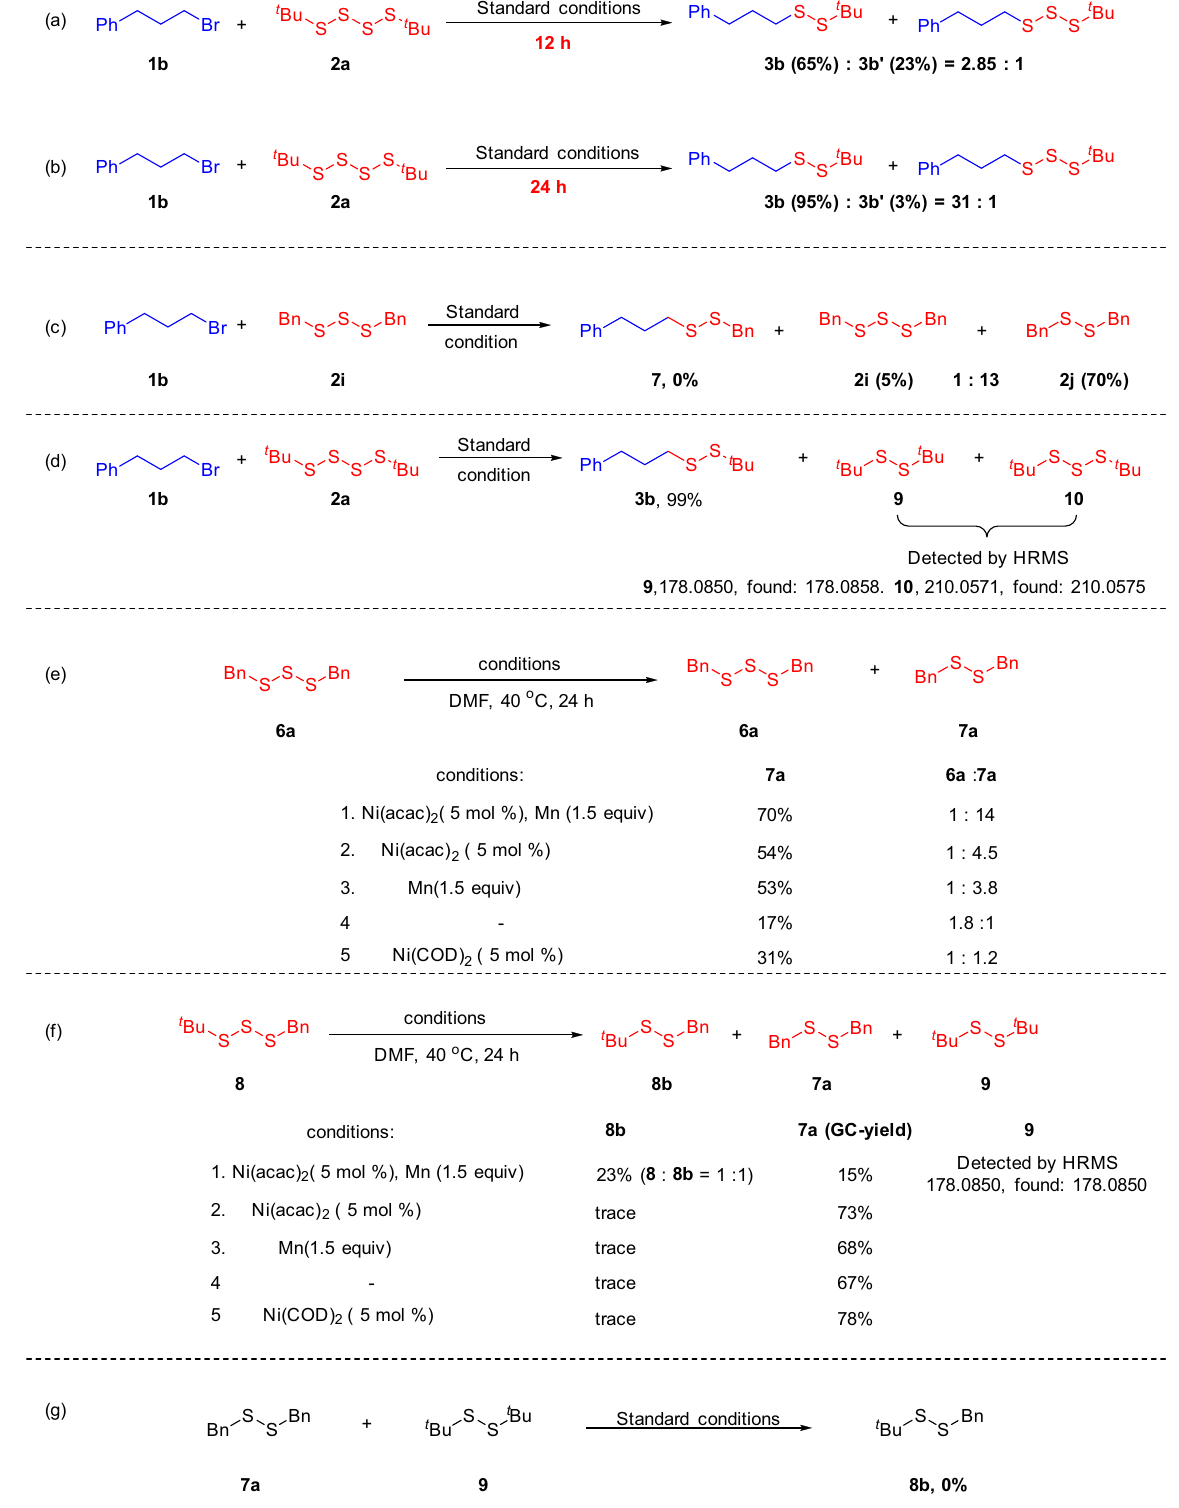
Fig. 5 Key mechanistic fi ndings. a The reaction of 1b and 2a under standard conditions for 12 h. b The reaction of 1b and 2a under standard conditions for 24 h. c The reaction of 1b and 2j under standard conditions for 24 h. d The catalytic system was analyzed by high-resolution mass spectrometry. e Investigation on the reaction mode of trisul fi de 6a under different conditions. f Investigation on the reaction mode of unsymmetrical trisul fi de 8 under different conditions. g The reaction of 1,2-dibenzyldisulfane 7a and 1,2-di-tert-butyldisulfane 9 under standard conditions for 24